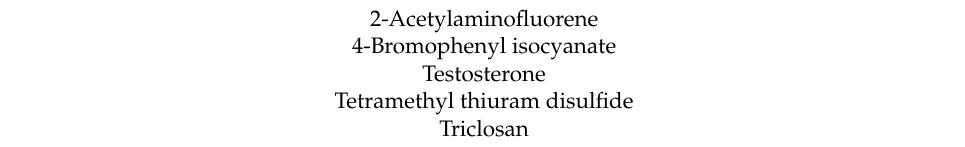
Table 2. Compounds tested in an ethanol solvent in [5] and selected for model